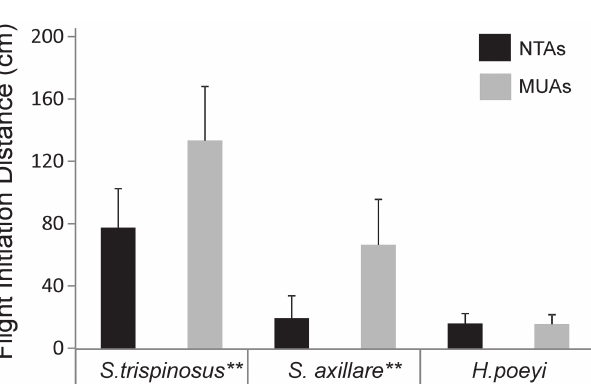
Fig. 3. Mean of flight initiation distances for the three labrid species studied in MUAs (Multiple-use areas) and NTAs (No-take areas) in Abrolhos. The upper limits of lines indicate standard deviation; *symbols indicate significant differences according to ANCOVA; **(p <